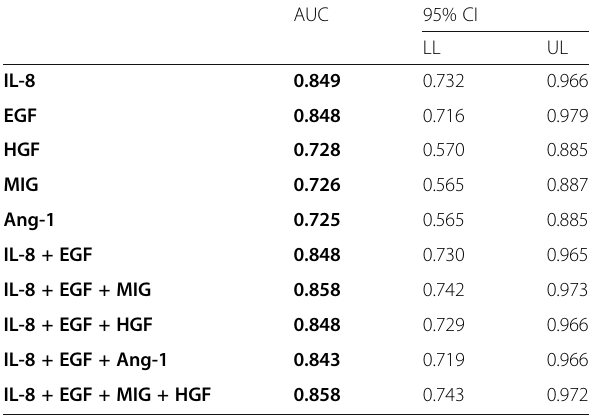
Ang-1 angiopoietin-1, AUC area under the curve, CI confidence intervals, EGF epidermal growth factor, HGF hepatocyte growth factor, IL-8 interleukin-8, MIG monokine induced by interferon gamma, LL lower limit, UL upper